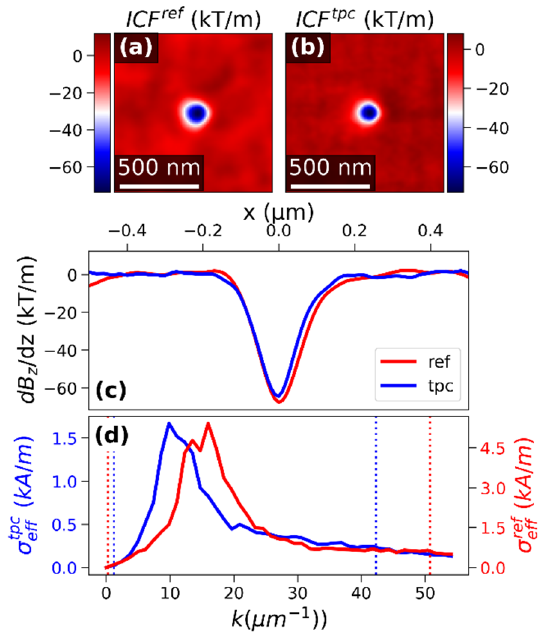
Figure 6. Comparison of ICFs and reference sample spectra: ( a , b ) show the ICFs calculated from calibration measurements using the Co/Pt ( ICF ref ) and the Ti/Pt/Co ( ICF tpc ) reference sample, respectively; ( c ) shows plotlines through the maxima of the TTFs for both calibrations, TTF ref (red) and TTF tpc (blue) for a distance of 64 nm from the tip apex; ( d ) shows plotlines through the Fourier spectra of the effective surface charge density of the Co/Pt reference sample (red) and Ti/Pt/Co sample. Dotted line marks the area of k-values accessible after calibration with the respective reference sample (see text).